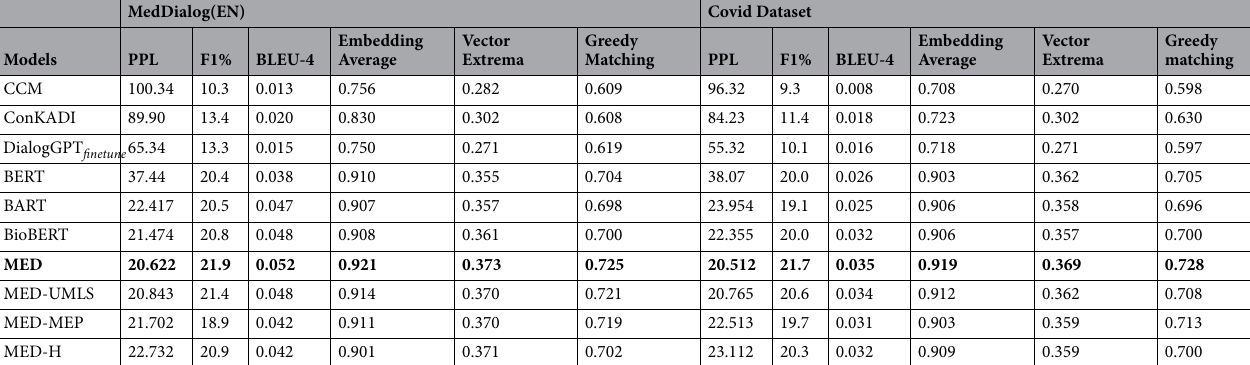
Table 6. Automatic evaluation results for the baseline and suggested model were achieved using the MedDialog(EN) corpus and the Covid Dataset. The bolded results represent the best outcome for the metric, with statistically significant improvement over the best baseline (t-test with p-value at 0.05 significance level).